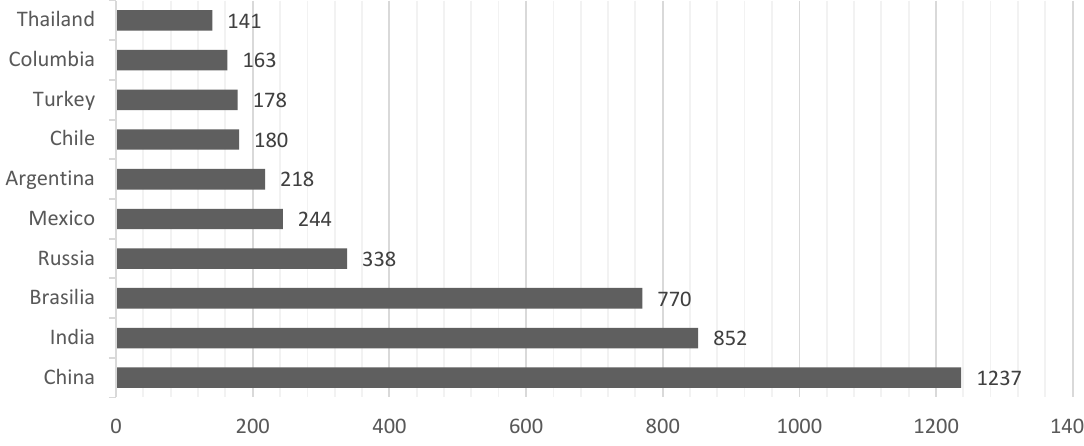
Figure 2. Top-10 countries using the PPP mechanism, number of